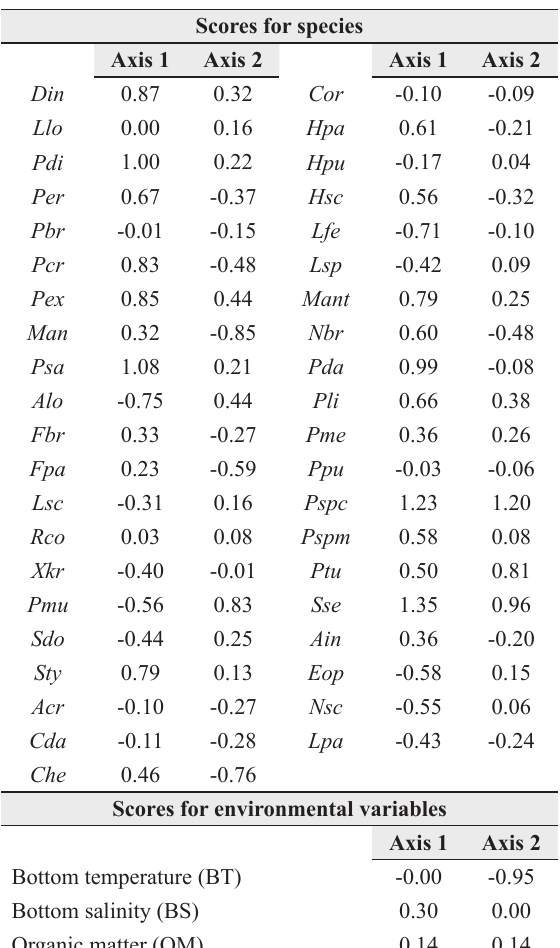
Scores for species and environmental variables based on the canonical correspondence